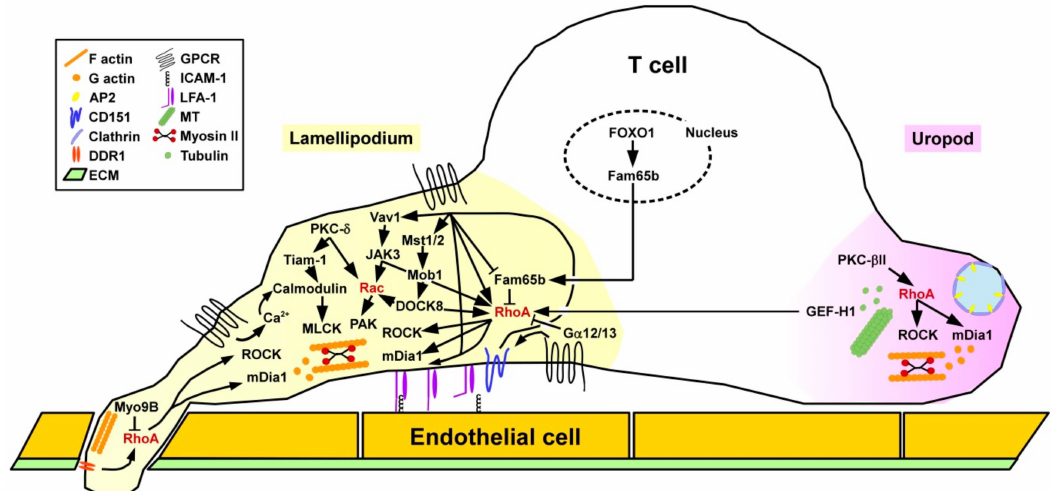
Figure 7. Migration of T cells is regulated by spatially regulated activity of RhoA and other small GTPases. Chemokine-induced T cell migration is conferred by dynamic regulation of the small GTPases RhoA / Rac at the front and of RhoA at the rear end. The activity of small GTPases is di ff erentially regulated by GEF (e.g., GEF-H1), GAP (e.g., Myo9B), and other factors (e.g., JAK3, Fam65b, PKC). Microtubuli turnover and the presence of clathrin structures contribute to the migratory